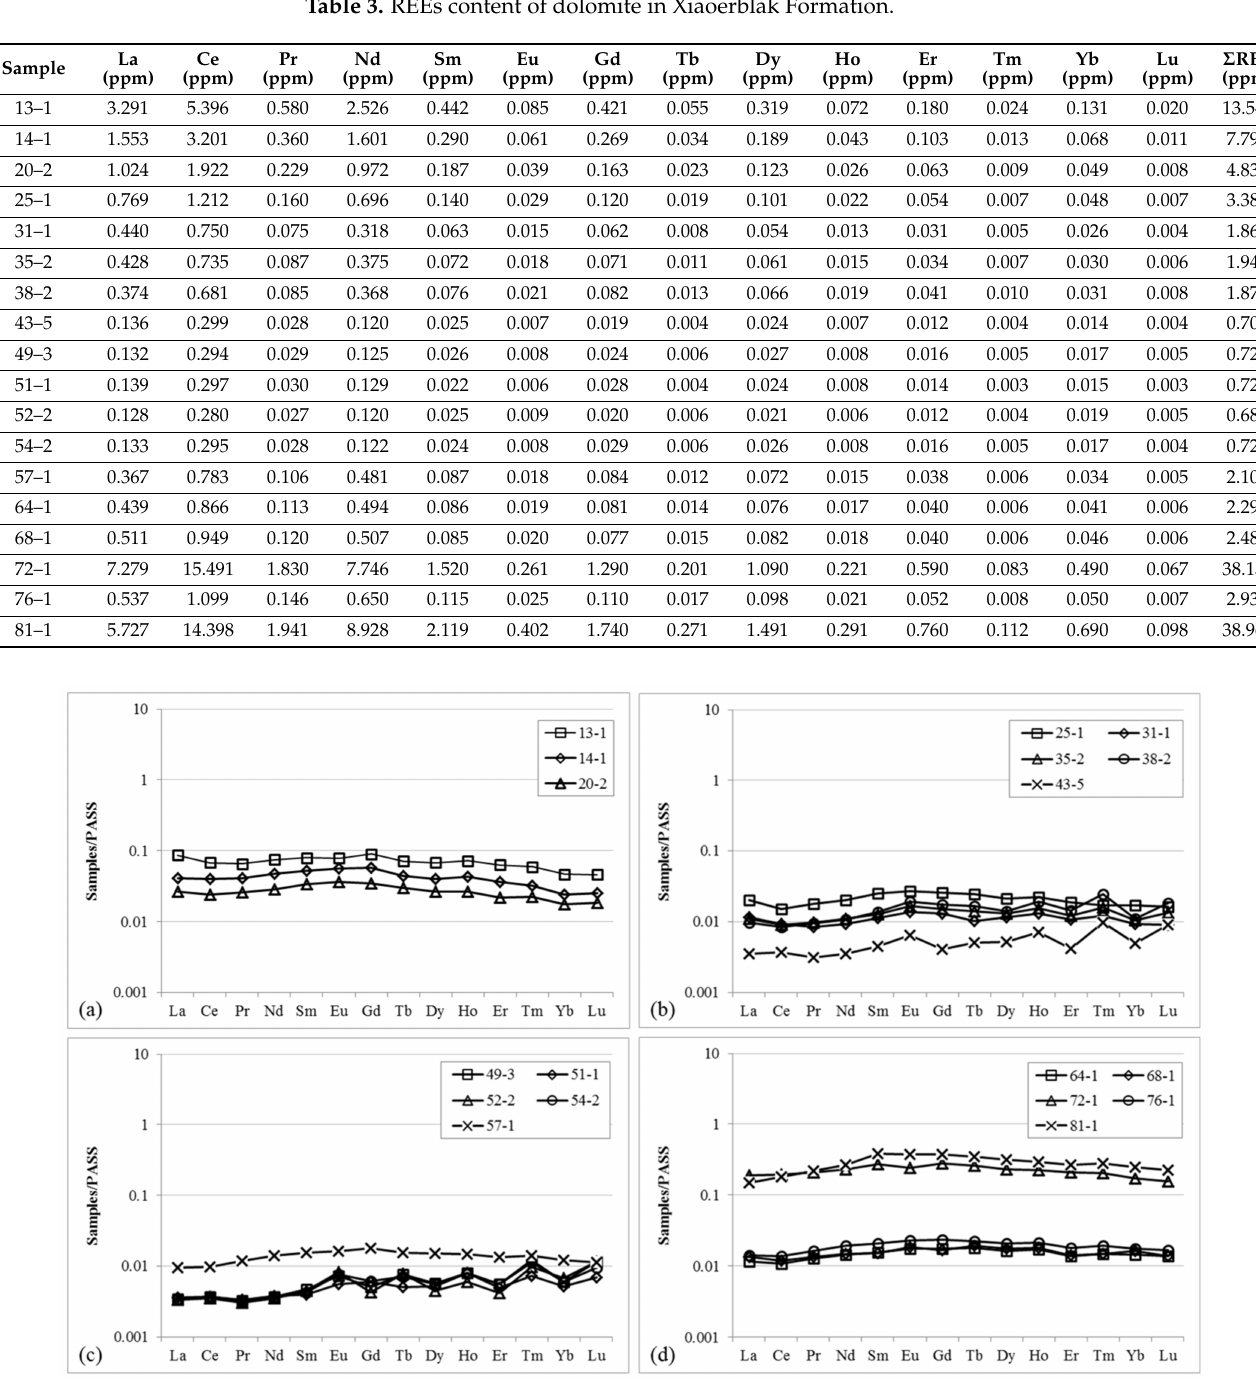
Figure 7. Normalized REEs distribution patterns of dolomite in Xiaoerblak Formation dolomite: ( a ) member Xi 1; ( b ) submember Xi 2 1 and Xi 2 2 ; ( c ) submember Xi 2 3 ; ( d ) member Xi